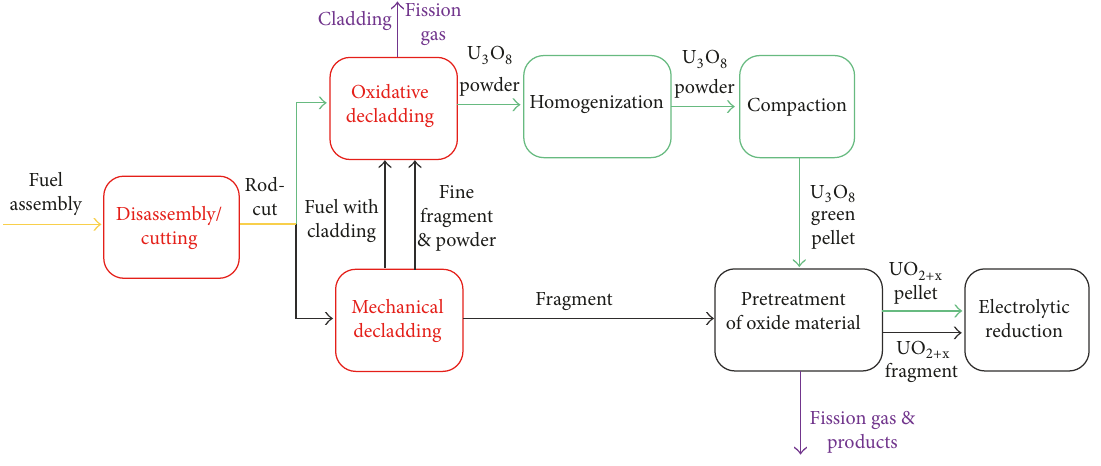
Figure 1: Flow chart of the head-end